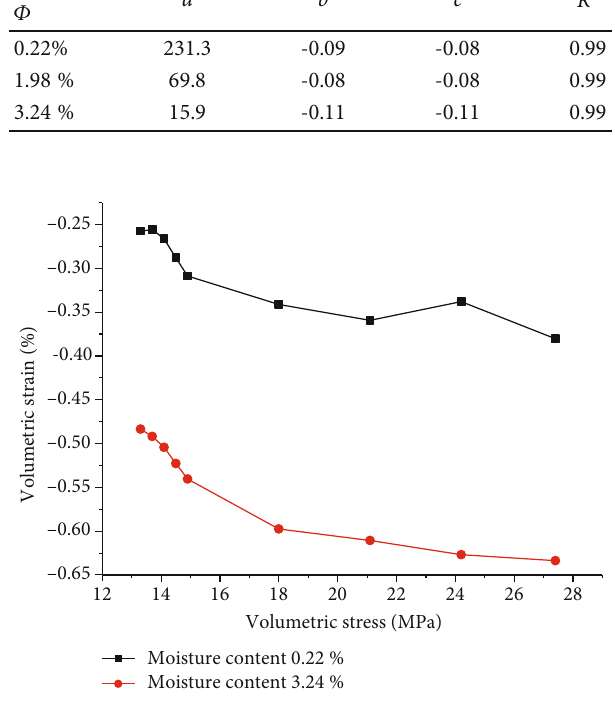
Figure 8: Volumetric stress Θ -strain e curves of samples with di ff erent moisture